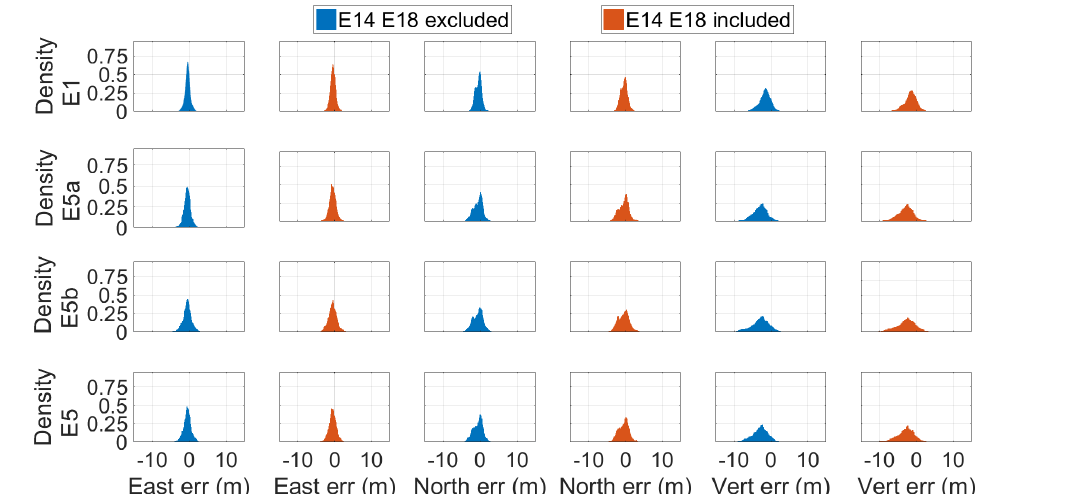
Figure 12. Density histograms of the E1, E5a, E5b, and E5 single-point position coordinates’ error. Each line refers to a specific frequency: the first from above refers to the frequency E1, the second to E5a, the third to E5b, and the fourth to E5. Blue and red histograms were obtained excluding and including the measurements coming from the Milena (E14) and Doresa (E18) satellites, respectively. Solutions were achieved by using broadcast